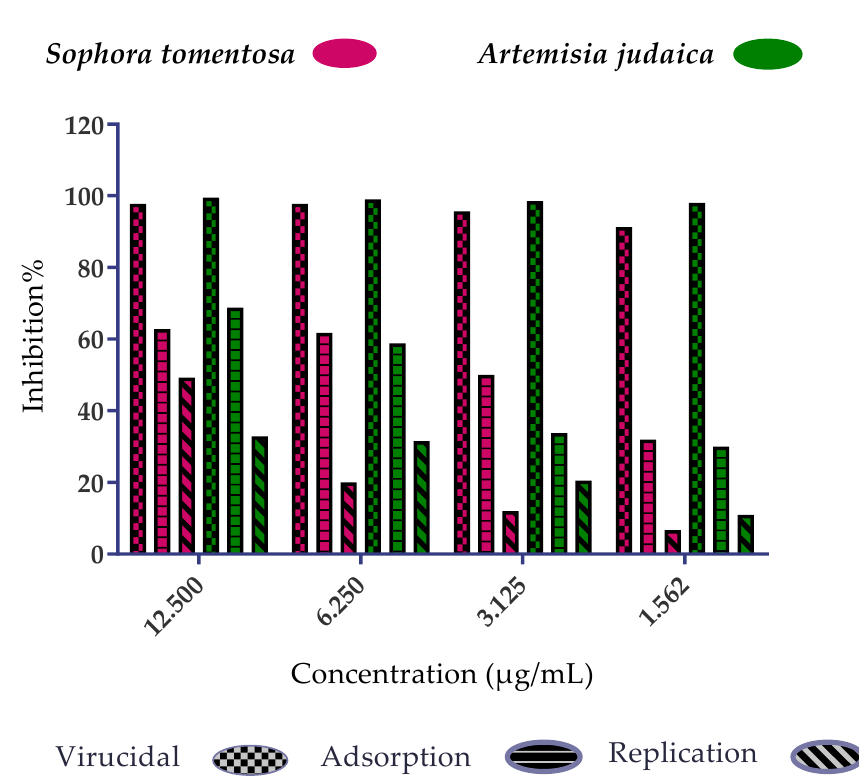
Figure 3. Mode of action for the two promising medicinal plants: S. tomentosa (Crude) and A. judaica (known shih-Balady), with different safe concentrations against MERS-CoV isolates (NRCE-HKU270 (Accession Number: KJ477103.2)). The virucidal effect was the main mode of action for the two extracts but has less effect on viral adsorption and a very low effect on viral replication.